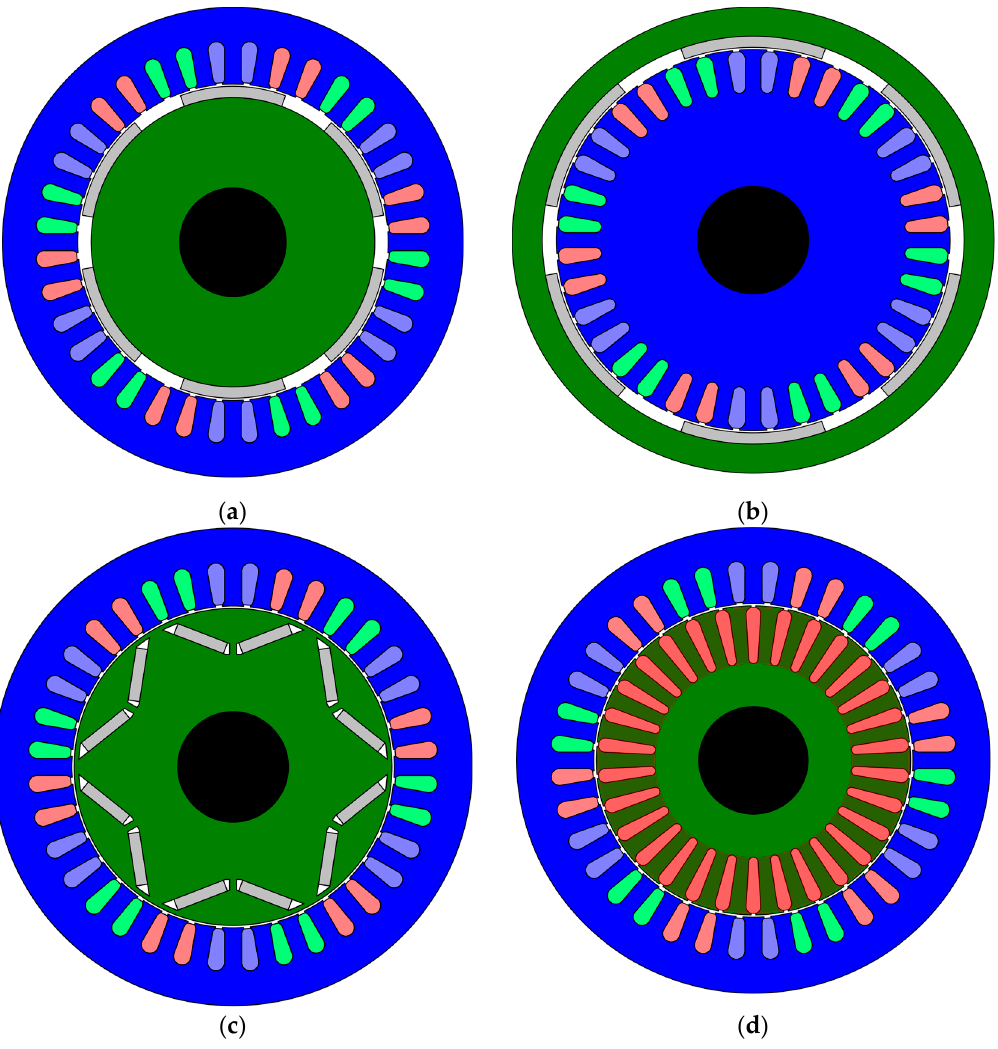
Figure 2 . Types of motors reviewed in the publications: ( a ) SPM, ( b ) ORSPM, ( c ) IPM, and ( d ) IM.